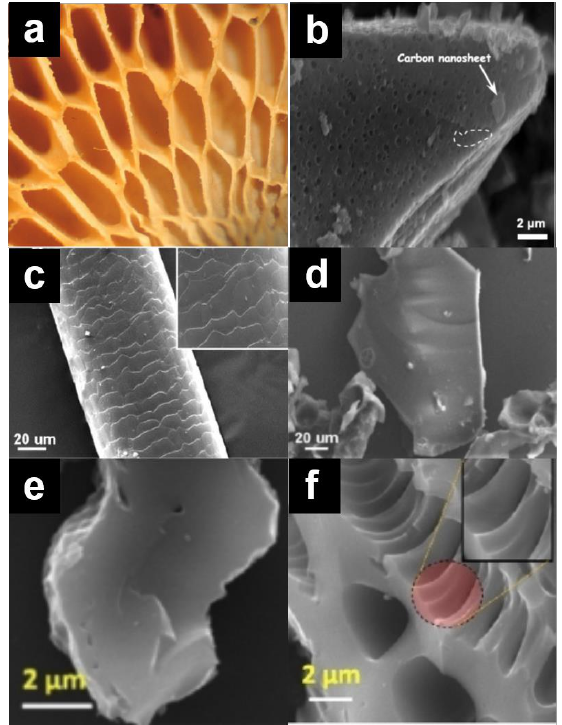
Figure 8. SEM images showing the microstructures of the precursors and the corresponding biomass-derived carbons, including ( a ) the hymenium of auricularia. Reproduced from [121], with permission from Elsevier, 2007; and ( b ) the porous layer-stacking carbon. Reproduced from [26], with permission from Elsevier, 2015; ( c ) human hair and ( d ) the micro/mesoporous carbon. Reproduced from [18], with permission from Royal Society of Chemistry, 2014; the carbonized orange peel before ( e ) and after ( f ) KOH activation. Reproduced from [122], with permission from John Wiley and Sons, 2017. The magnified SEM images in c and f showed the enlarged view of the hair-surface feature and the porous structure of the activated orange peel, respectively.